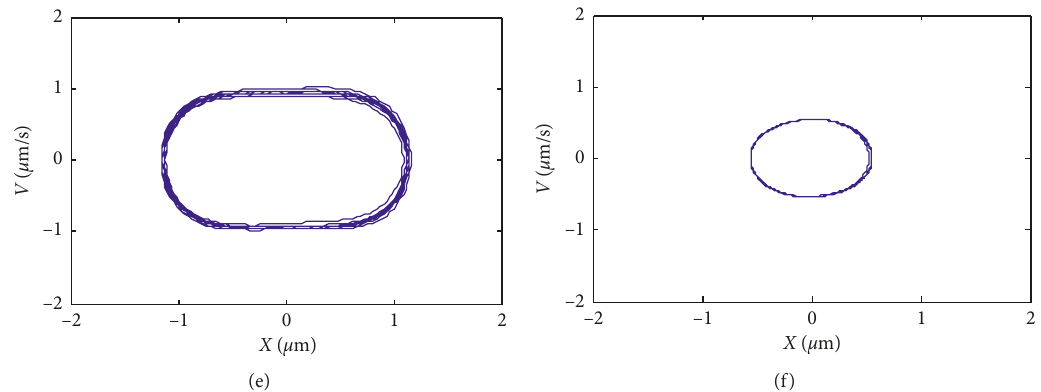
Figure 11: Phase diagram. (a) C � 5, (b) C � 7, (c) C � 150, (d) C � 200, (e) C � 220, and (f) C � 280.